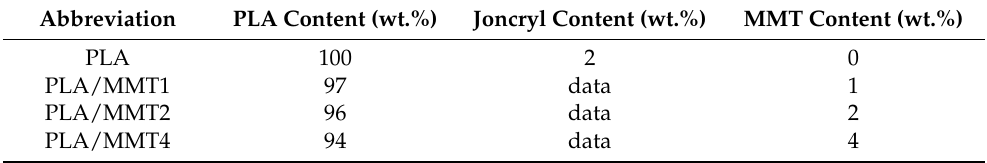
Table 2. The composition and abbreviations of the fabricated